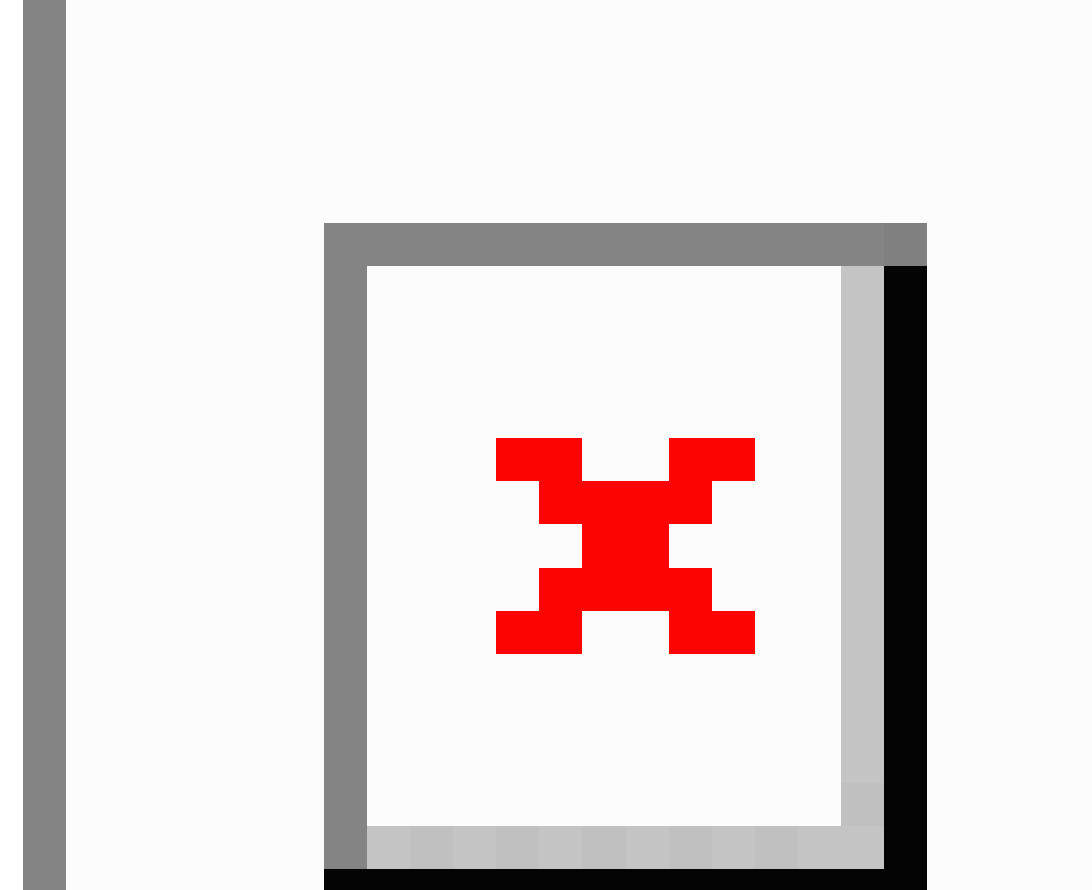
Figure 1. Sample CDS output with complete information and color